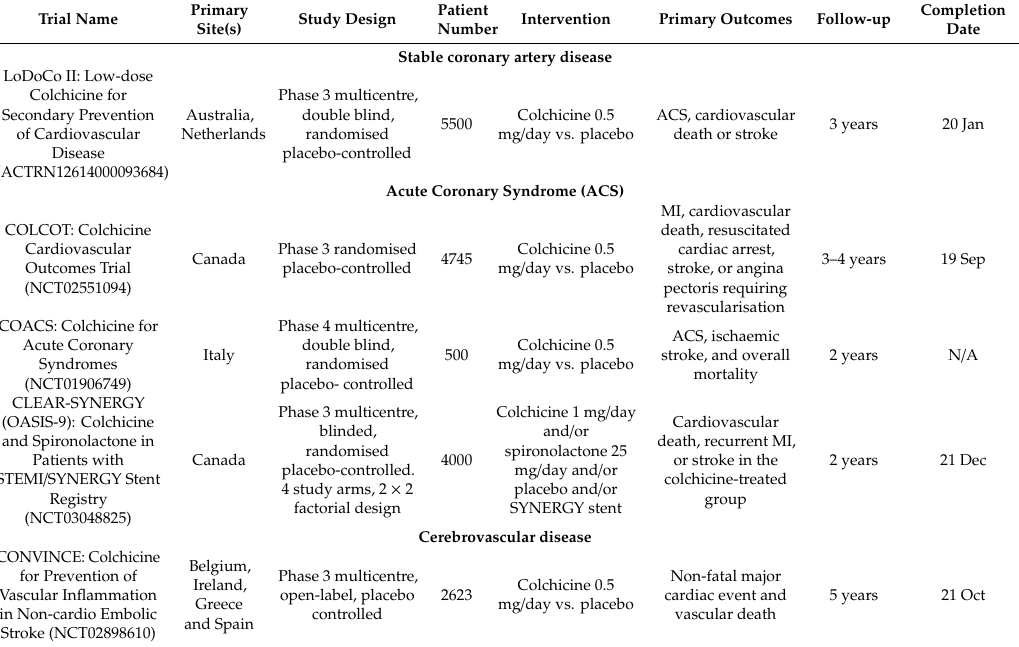
Table 2. Ongoing clinical studies involving colchicine in cardiovascular